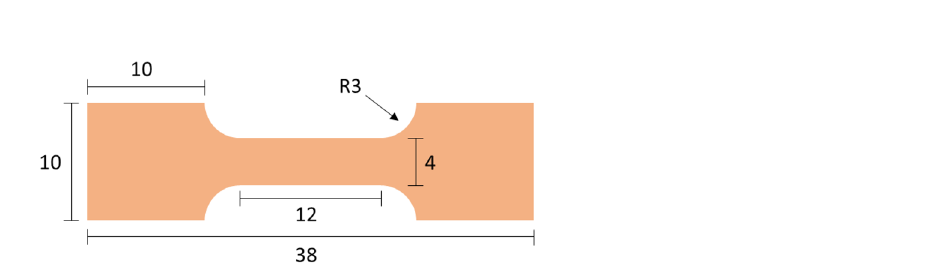
Figure 1. ( a ) Top-view and side-view structures of the electroplated substrate at the cathode and ( b ) a schematic of the electroplating facility.